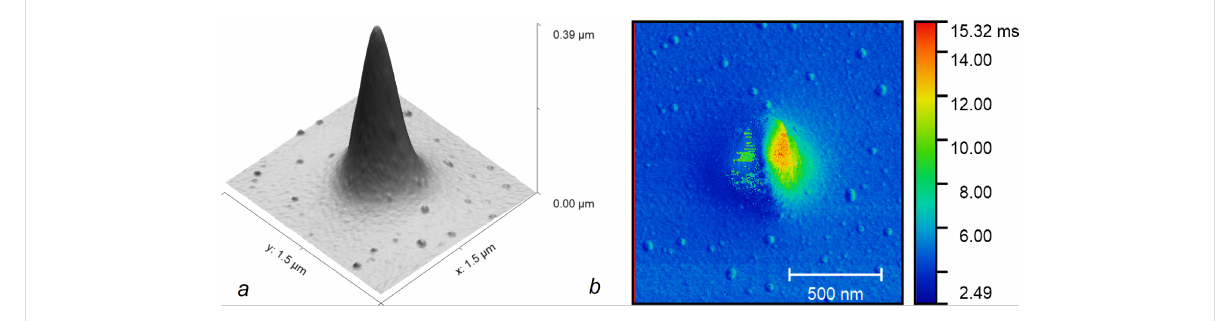
Figure 3: AFM image of the tip on a test grating TGT1 (a); time of the measurement at a point (b).